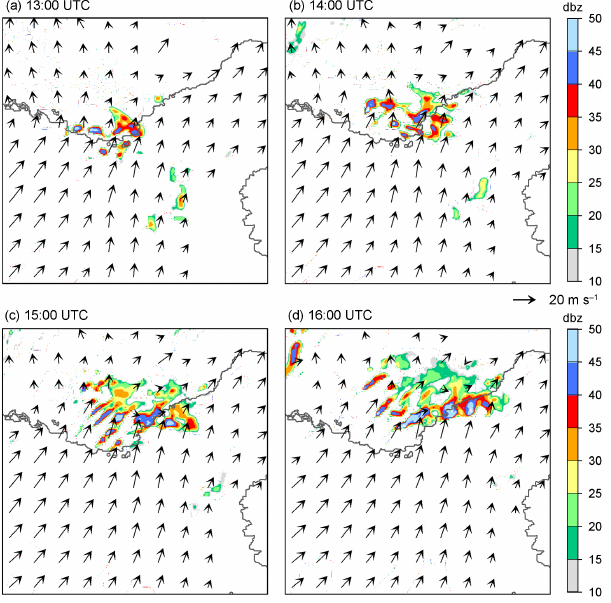
Figure 4. Equivalent potential temperature θ e at 925hPa (K, red areas), virtual potential temperature θ v at the first model level (K, blue areas below 291K), vertical motion at 500ma.s.l. (green areas above 0.5ms − 1 ), and horizontal wind at 925hPa (arrows) simu- lated by CNTL at (a) 14:00, (b) 15:00, (c) 16:00, and (d) 17:00UTC on 14 October